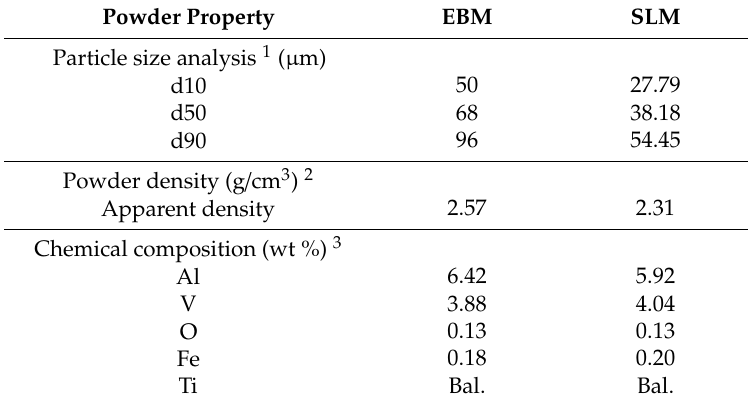
Table 1. Compositions and properties of the analyzed Electron Beam Melting (EBM) and (Selective Laser Melting (SLM) Ti64 powders. Data were collected following the related ASTM international standards. Powder